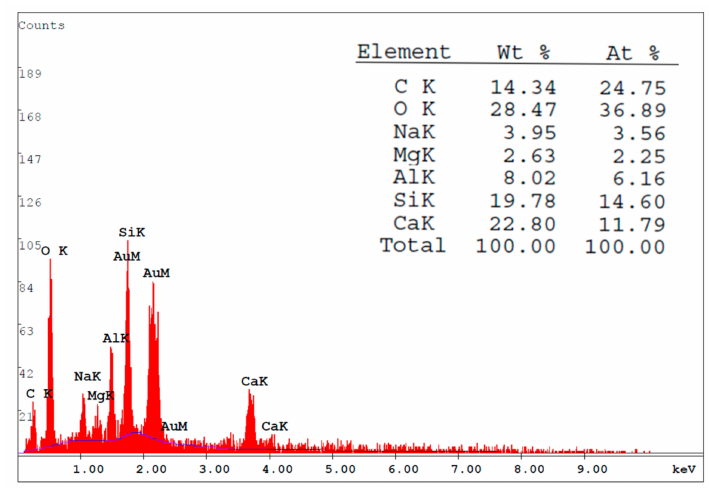
Figure 14. The energy-dispersive X-ray spectroscopy (EDX) component analysis of interface interphase when FGG was repaired with